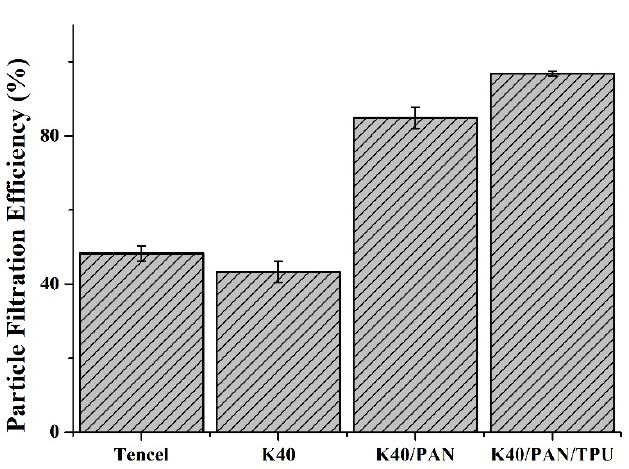
Figure 8. Sub-micron particulate filtration efficiency of Tencel, K40, and K40/PAN/TPU lay-up compound matrices.